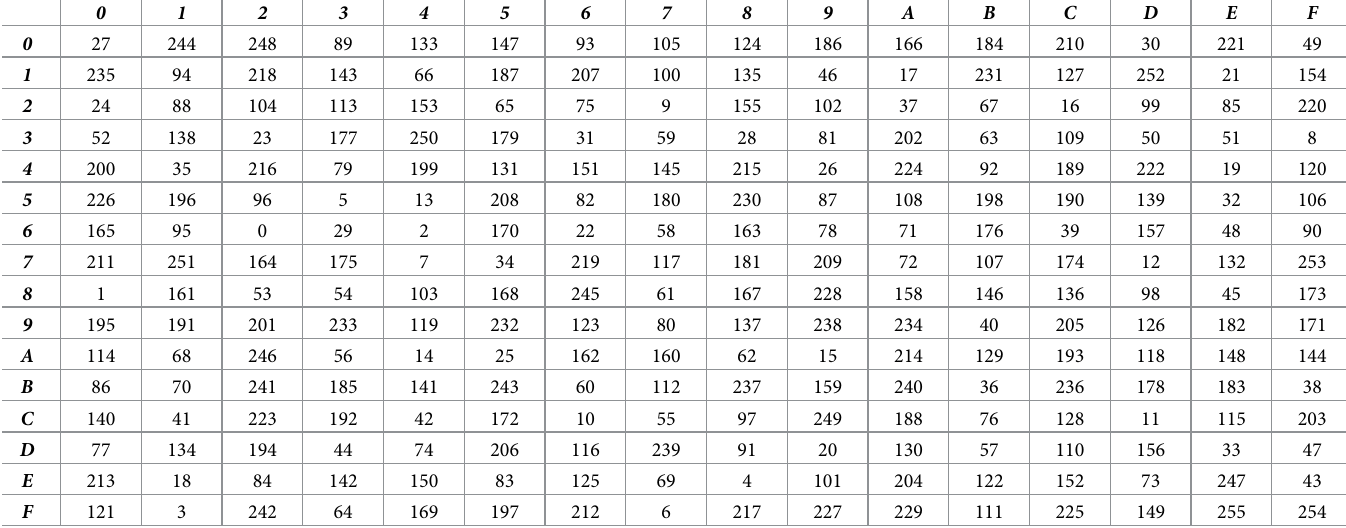
Table 9. Proposed S-box (S8) in 16 × 16 matrix form—generated with T 8